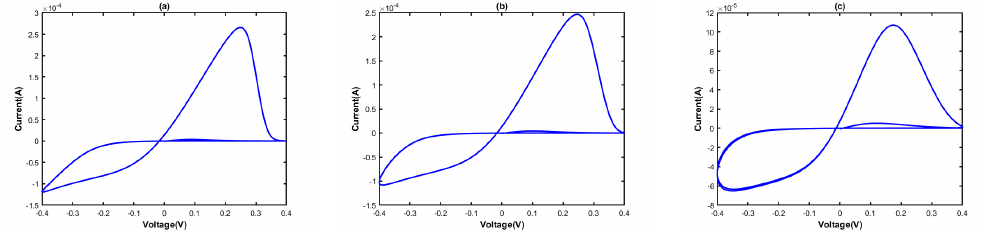
Figure 7. Voltage − current curves of varying capacitance, for 16 nm: ( a ) 33 nF, ( b ) 51 nF, and ( c ) 100 nF.